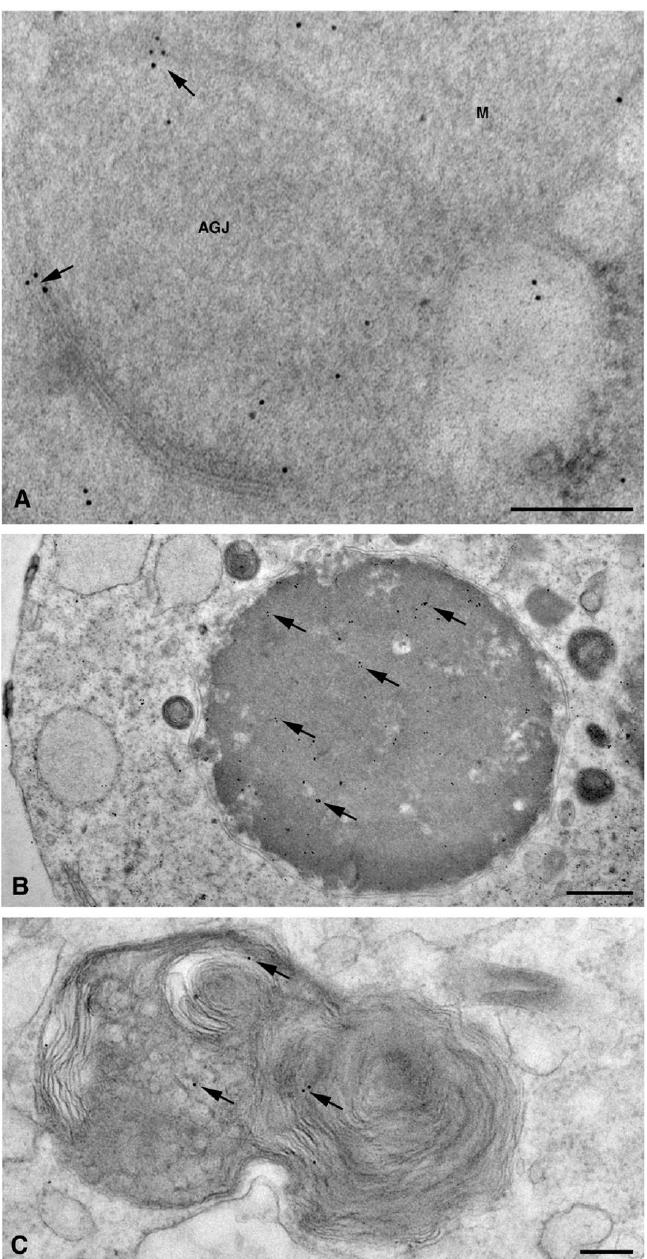
Figure 5. TEM immunogold analysis for Cx26 in delivery and degradation of subcellular structures. ( A ) Cardiomyocytes of heart tissue: representative image of an annular gap junction (AGJ), associated with a mitochondrion (M), showing immunogold reaction on (arrows) and inside the membrane. Scale bar 200 nm. ( B , C ) Representative images of autophagic vacuoles showing scattered gold particles (arrows) in dH9c2 cells. Scale bars 600 nm ( B ), 200 nm ( C ). The presence of Cx26 on non-canonical cell structures including nuclei, mitochondria, myofibrils, and sarcoplasmic reticulum (SR) has been found, for the first time, in the present study. In particular, mitochondrial immunopositivity was localized on both the inner membrane and, in a larger amount, on the cristae (Figure